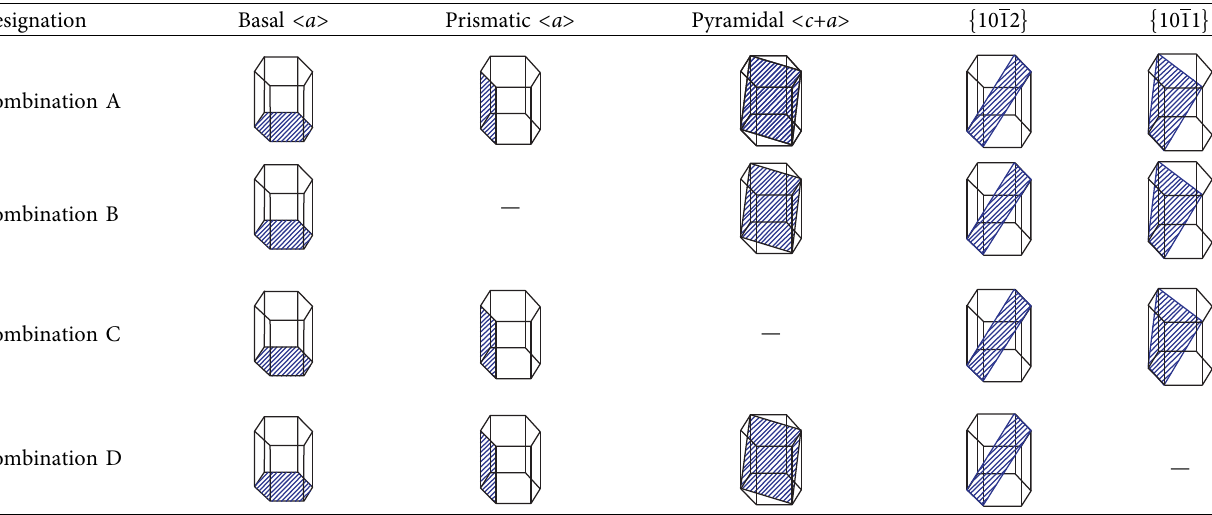
Table 2: VPSC model with different deformation